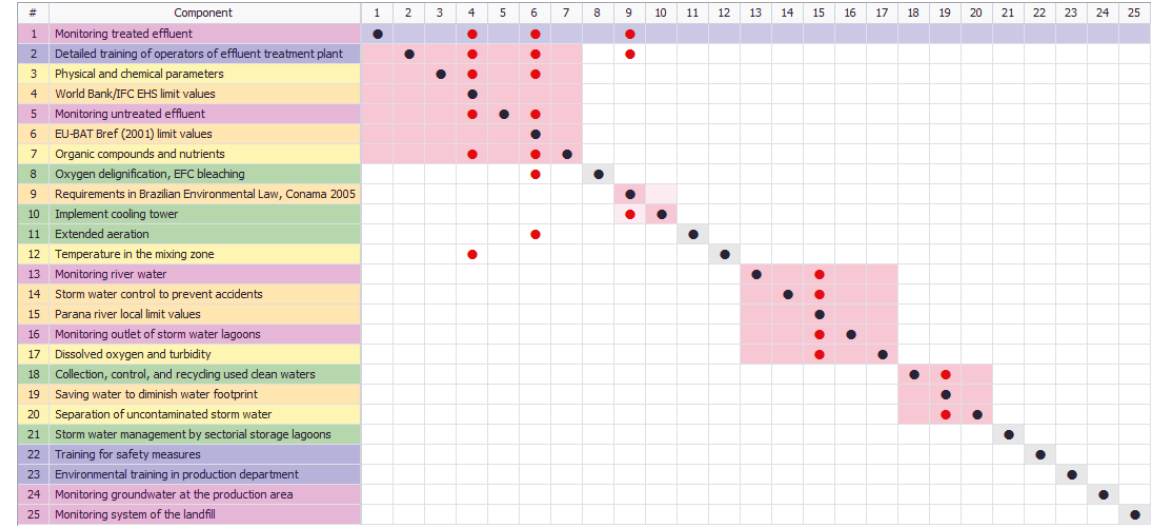
Figure 10: WWTP policy formulation process DSM after